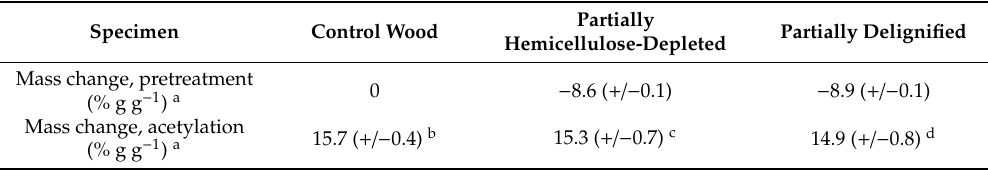
Table 2. Mass changes of wood after di ff erent